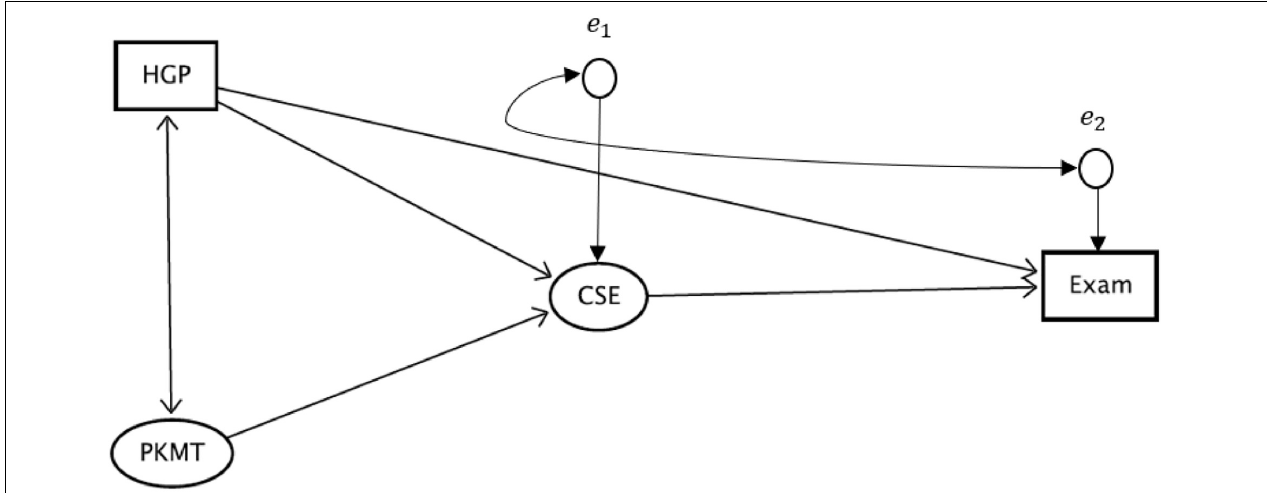
FIGURE 1 | The hypothesized model of the relationship between prior mathematics knowledge, self-efficacy, and students’ performance in an introductory calculus course. Both HGP and PKMT are measures of the prior mathematics knowledge of the students, CSE is a measure of the self-efficacy, and Exam represents a measure of performance. The items of both PKMT and CSE are not included in Figure 1 to enhance the readability of the figure.